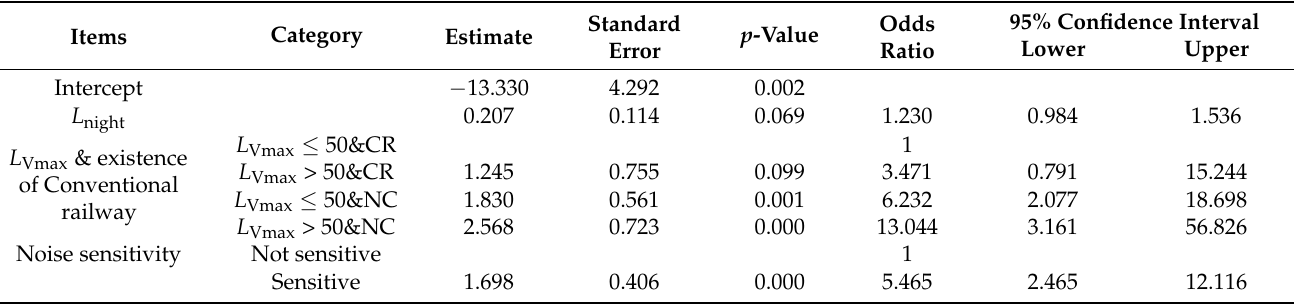
Table 6. Multiple logistic regression analysis of high sleep disturbance by L night , L Vmax and existence of conventional railway (AUC = 0.863).